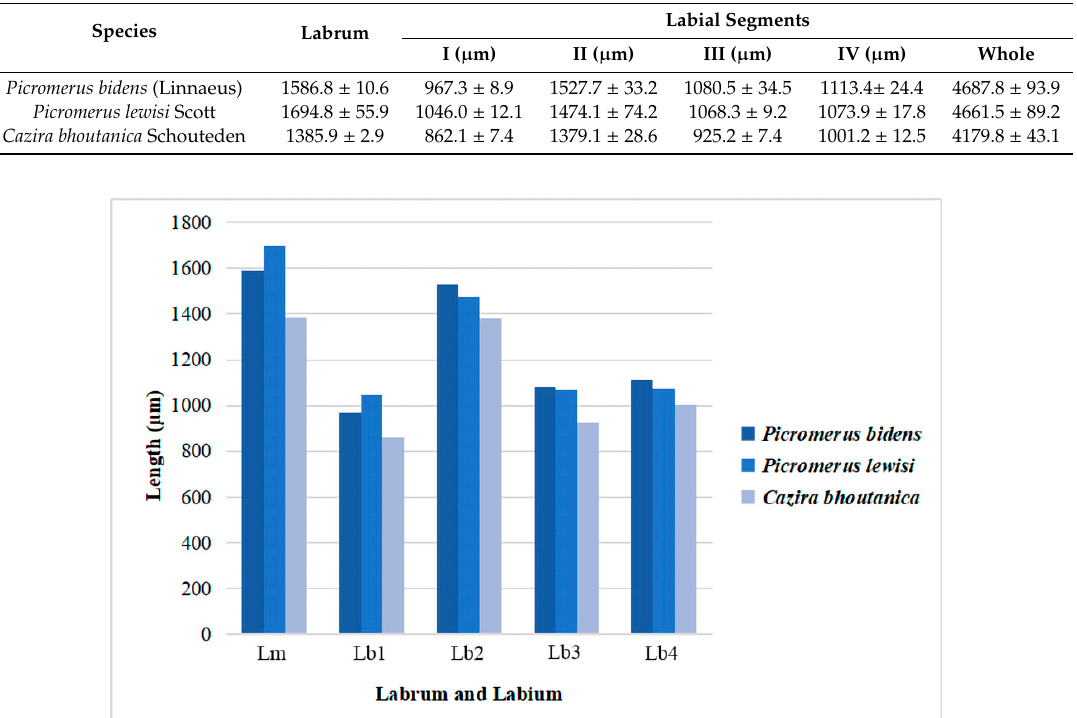
Figure 4. The length of labrum and each labial segment in different species. Lm, labrum; Lb1, 2, 3, and 4: the first, second, third, and fourth labial segments, respectively.